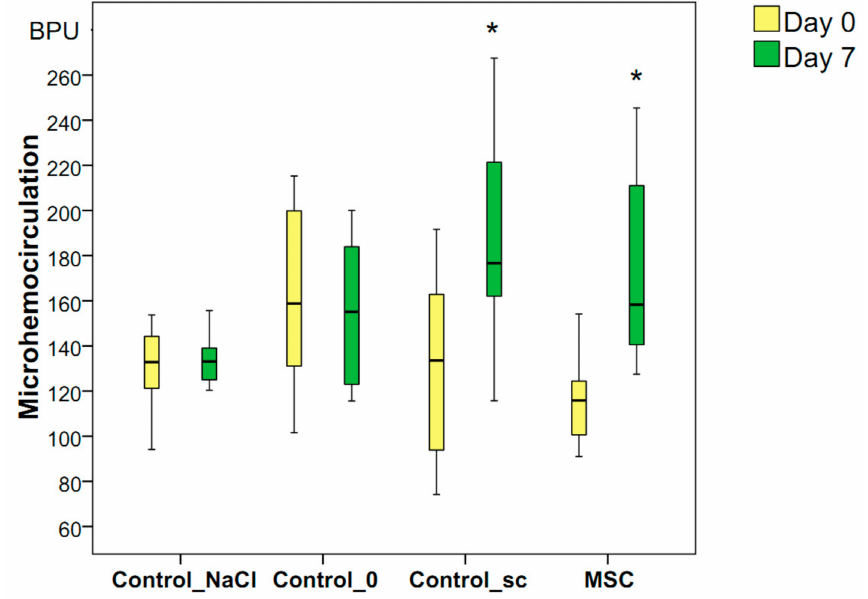
Figure 6. Microhemocirculation in the wound-edge tissues of different groups on days 0 and